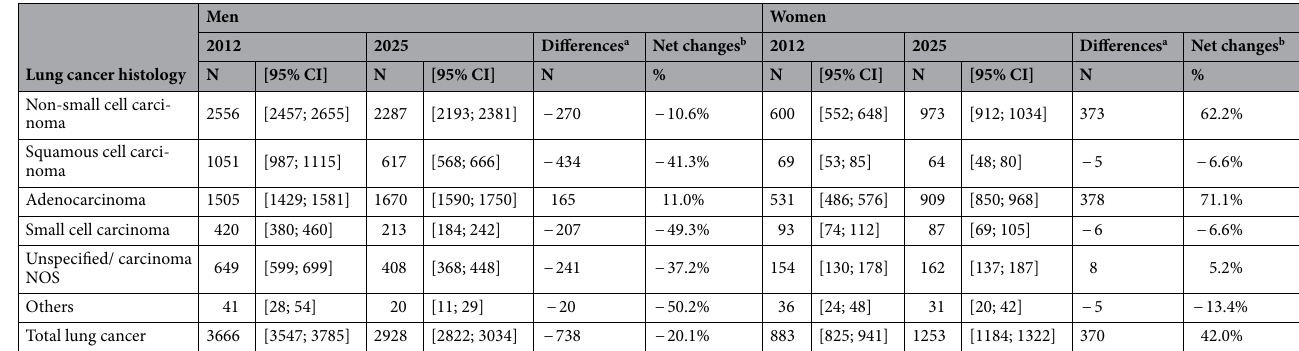
Figure 3A shows the projected incidence rates by age, sex, and histological type in 2015, 2020, and 2025. Adenocarcinomas show a decrease from 2015 to 2020 and 2025 in men aged up to 60 years and in women in younger age groups. For squamous cell carcinoma and small cell carcinoma, the incidence rate is expected to decrease in men of all age groups in 2020 and 2025, whereas the data project an increase by 2025 in women aged 60 or older. If we consider the analysis by year of birth (Fig. 3B), the incidence rate shows an increase in adeno- carcinomas in men born before the 1950s, while in younger cohorts, the rates decrease gradually and eventually stabilize. A similar trend is apparent in women, although the incidence rate only starts to decrease in the cohorts born after 1960. In squamous cell carcinoma and small cell carcinoma, the incidence rates consistently decrease with the age of the cohort; for women, this pattern is seen only in those born after 1960. Men born before 1960 showed a higher relative risk of incident lung cancer for all histological types. In con- trast, women at the highest relative risk were those born from 1958 to 1963 (Fig. 4).